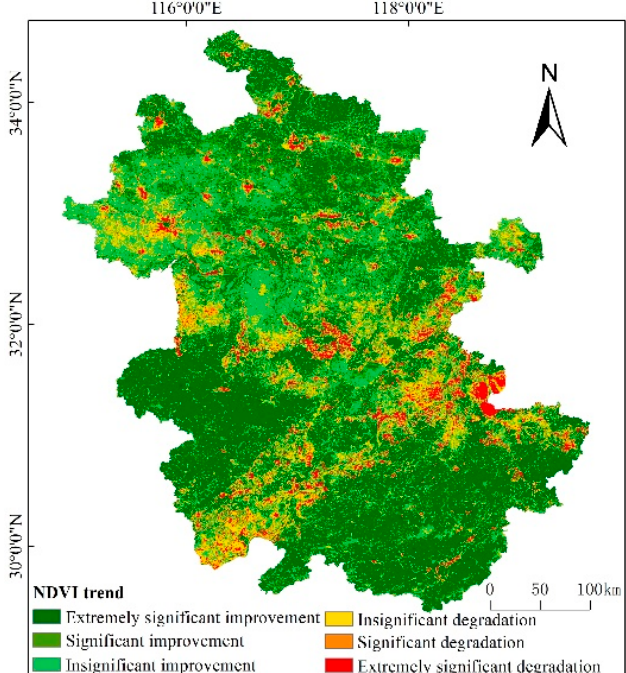
Figure 5. Spatial distribution of variation trend of NDVI in Anhui Province from 2001 to 2019. According to the change trend and significance test results of NDVI, the change trend was divided into 6 grades: extremely significant improvement, significant improvement, insignificant improvement, insignificant degradation, significant degradation, and extremely significant degradation. Table 1. Significant statistical results of variation trend of NDVI in Anhui Province.